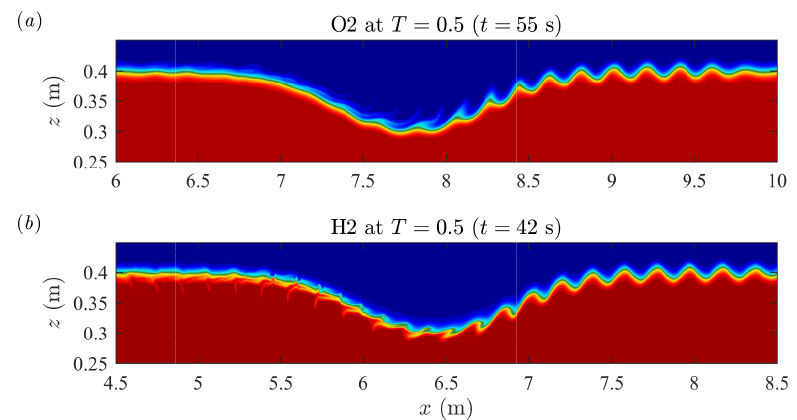
Figure 6. Detailed density contours of the simulations (a) O2 and (b) H2, showing the overturning of the linear waves during the collision.